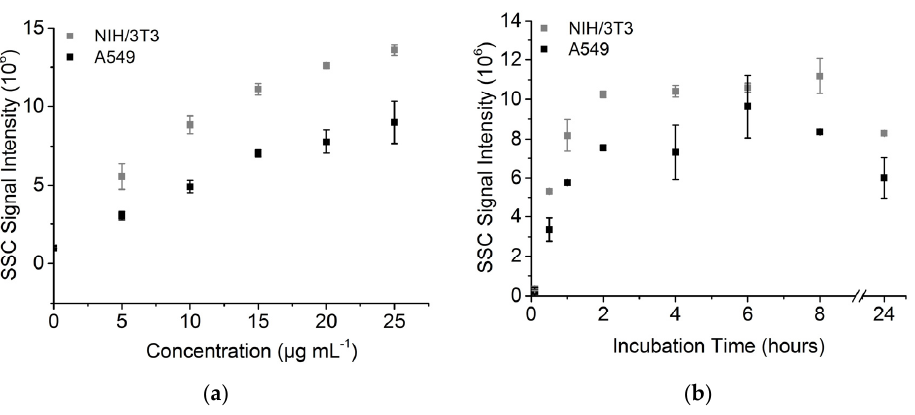
Figure 3. Side scatter signals of A549 and NIH/33 cells. ( a ) SSC after incubation with different FITC ‐ TiO 2 NP concentrations after 24 h incubation; ( b ) SSC signal kinetic of FITC ‐ TiO 2 NPs (12.5 μ g mL − 1 ).